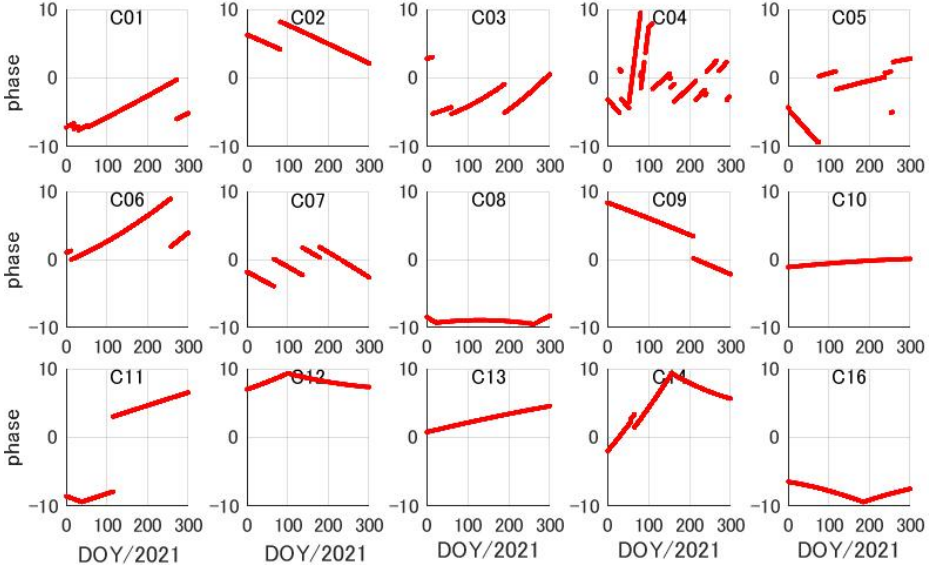
Figure 1. Clock bias series of the BDS-2 onboard clocks from DOY 1 to 300, 2021 (units: 10 − 4 s).